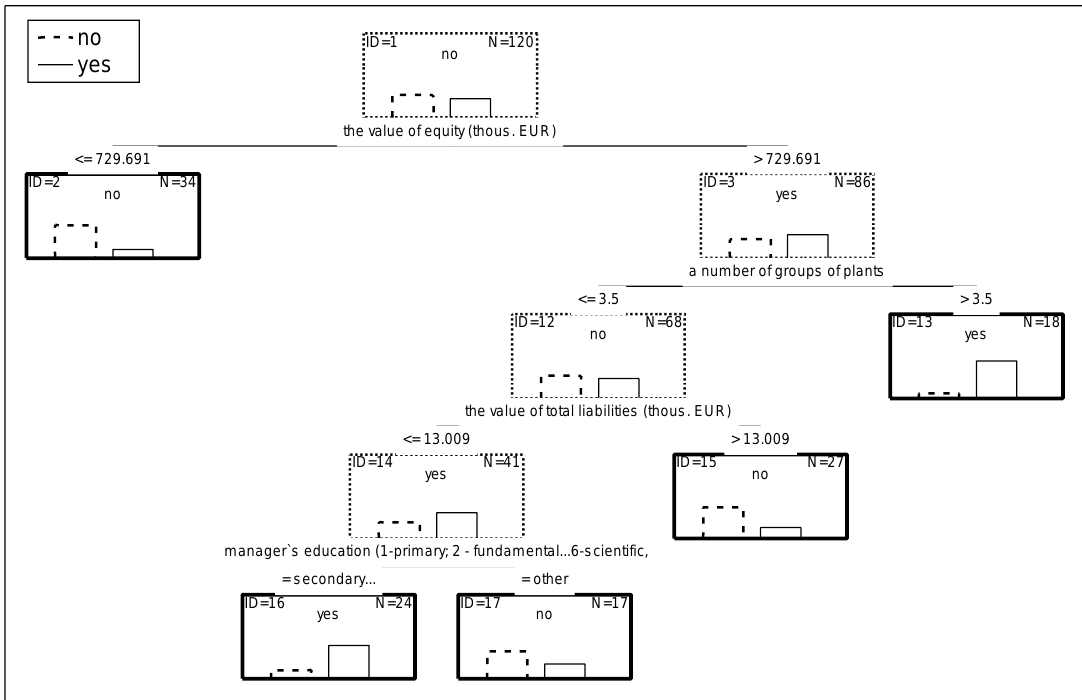
Figure 1. The model of the final classification tree (C&RT) in regards to the selection of the highest preference for the objective of “providing income” in the group of examined respondents (N = 120).